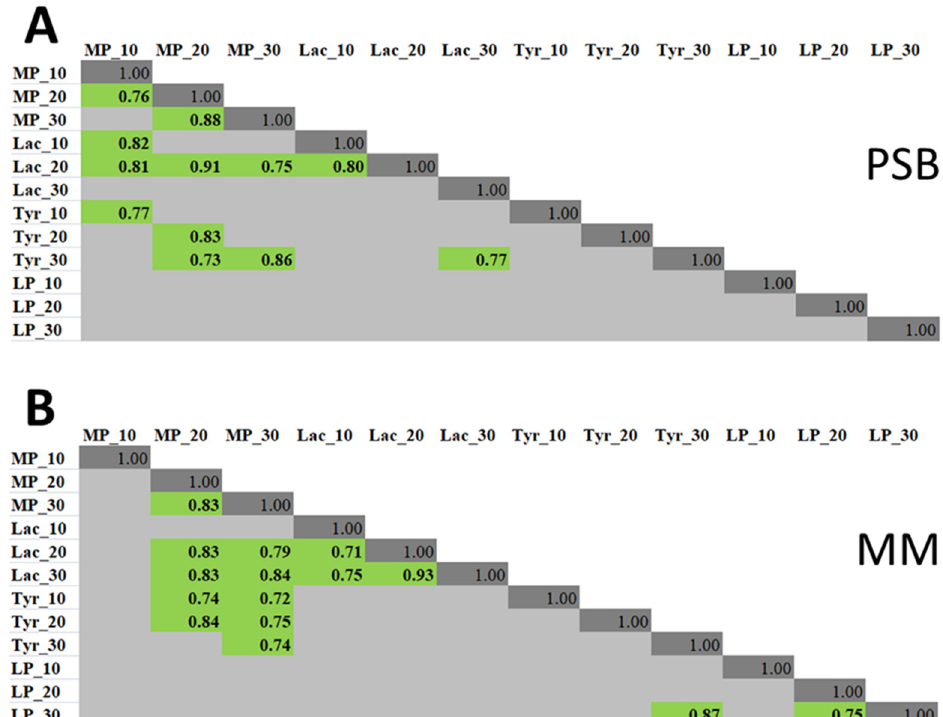
Figure 4. The correlation matrix of the levels of extracellular lignin peroxidase (LP), Mn peroxidase (MP), laccase (Lac), and tyrosinase (Tyr) activities of different Microdochium nivale strains grown in ( A ) potato sucrose broth medium (PSB) or ( B ) minimal medium (MM) for ten (10), twenty (20), or thirty (30) days. The presented values are Spearman correlation coefficients. Tests in which the correlations were insignificant ( t -test with Holm–Bonferroni adjustment, p -value < 0.05) are not shown.